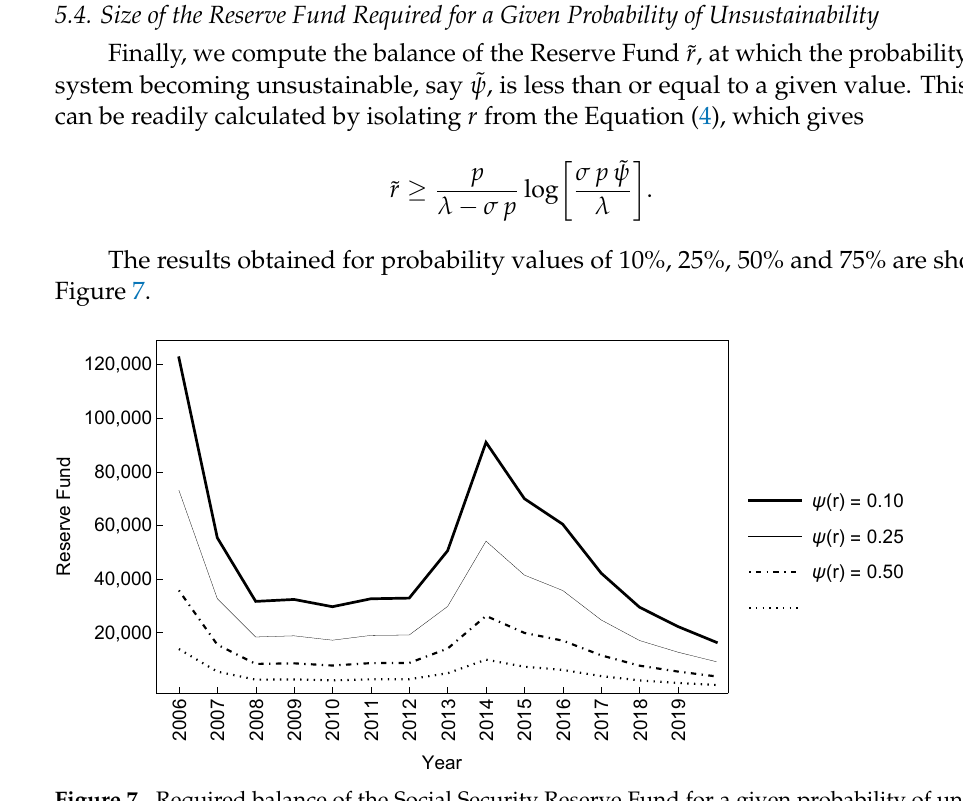
Figure 7. Required balance of the Social Security Reserve Fund for a given probability of unsustain- ability. Devised by the